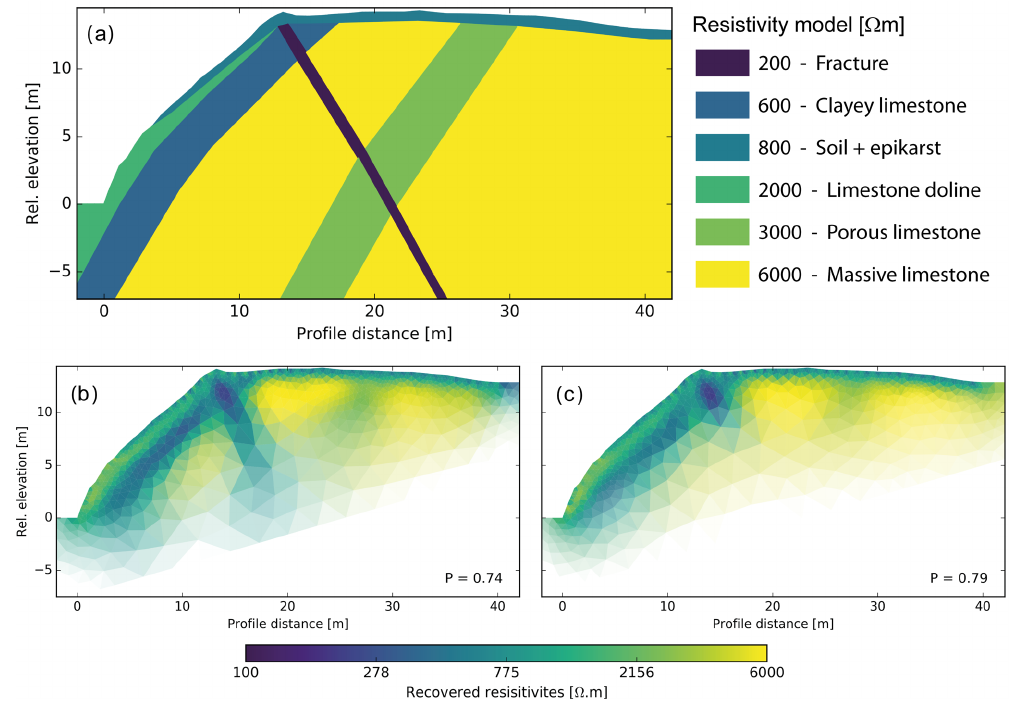
Figure 9. Results of the forward modelling of the resistivity model (a) for the DD protocol (b) and the GD protocol (c) . Pearson’s correlation coefficients ( P ) are computed for the data sets of March 2017 presented in Fig.